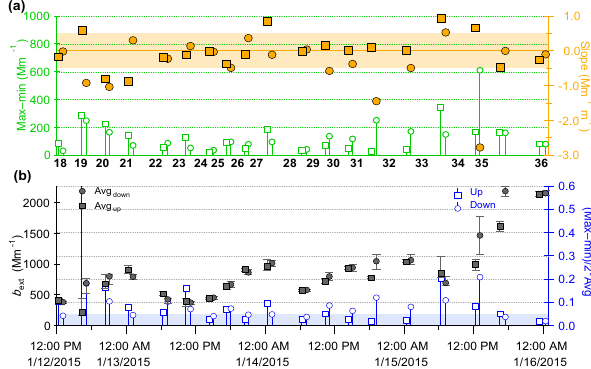
Figure 3. Time series of (a) vertical difference (max–min) and slope of extinction versus height and (b) extinction and vertical dif- ference ((max–min )/( 2 × avg)) for each vertical profile during the haze episode in January. The circles refer to the down profiles while boxes indicate the up profiles.